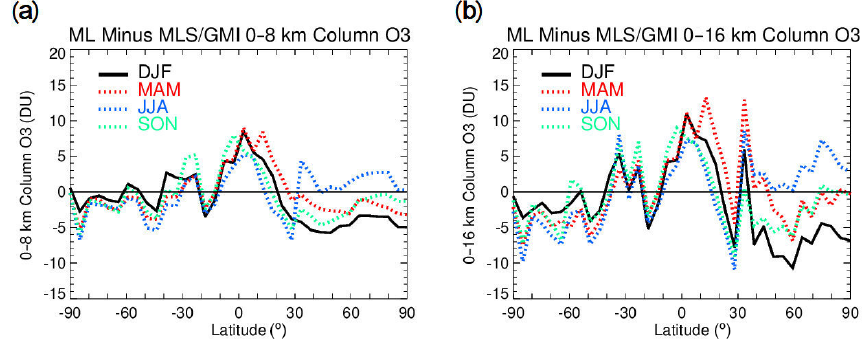
Figure 5. (a) Line plots of seasonal differences of ML minus MLS/GMI integrated ozone columns for 0–8km. The differences are averaged over 3-month seasons (indicated by DJF, MAM, JJA and SON). Panel (b) is the same as panel (a) but for 0–16km ozone columns.